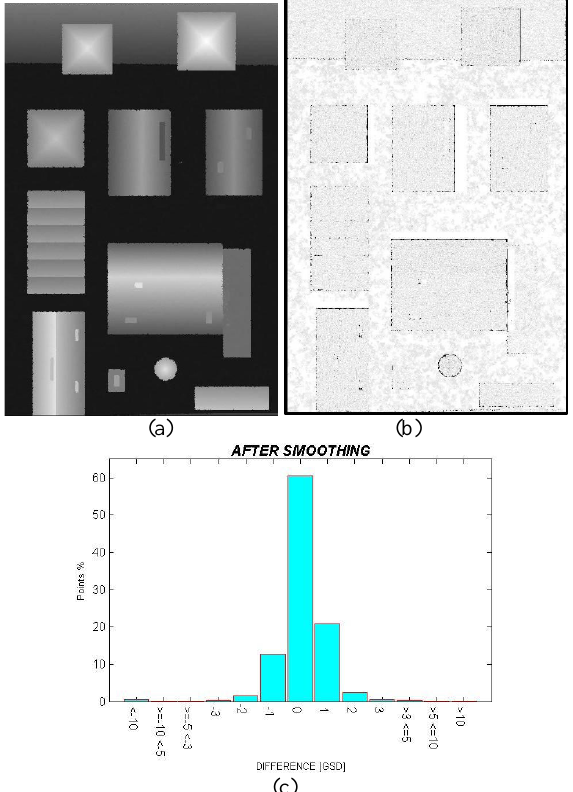
Figure 7: denoised DSM (a), differences between ground truth and the smoothed DSM using the proposed algorithm (b) and histogram of the differences